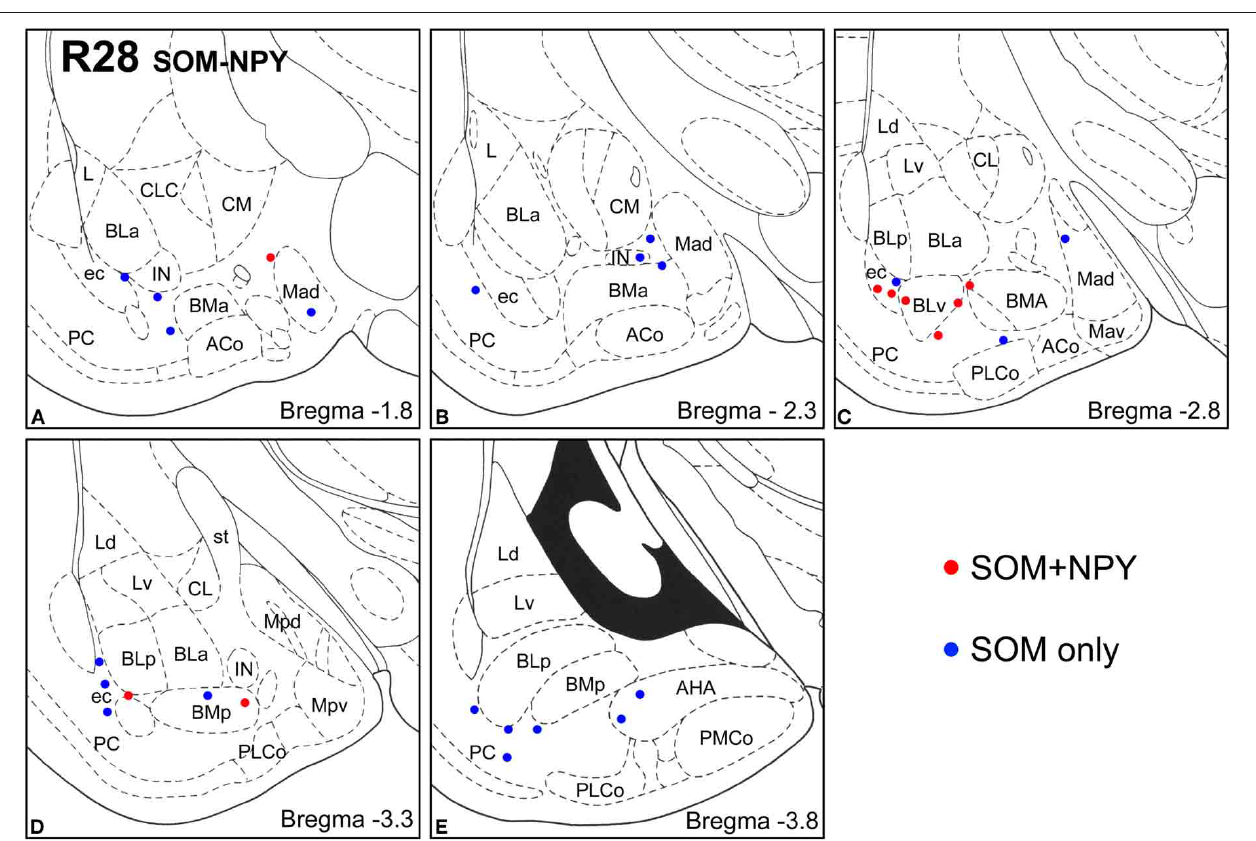
FIGURE 6 | Sections arranged from rostral (A) to caudal (E) depicting the locations of long-range non-pyramidal neurons in the amygdalar region expressing SOM and NPY in case R28. Each dot represents one neuron.